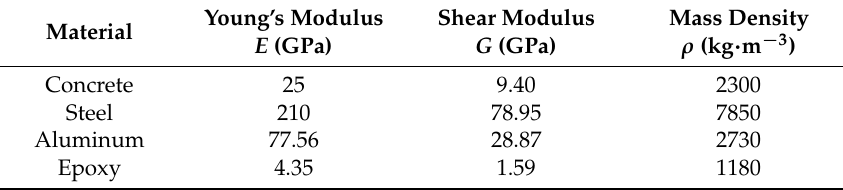
Table 2. The material constants of the four materials